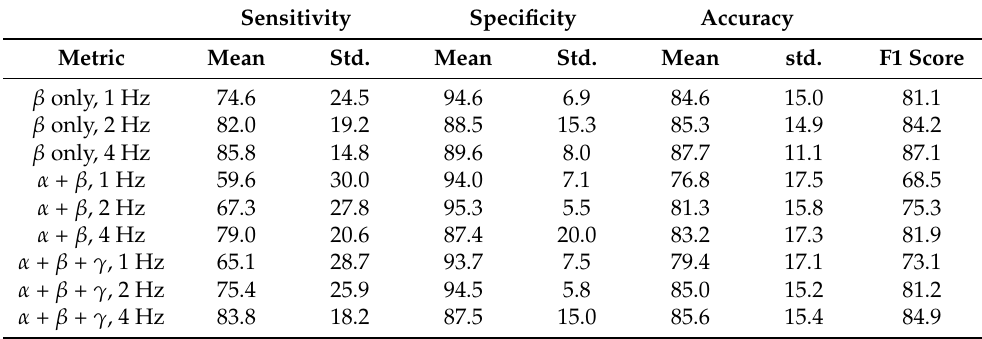
Table 4. Results for reproducible test. The numbers given are